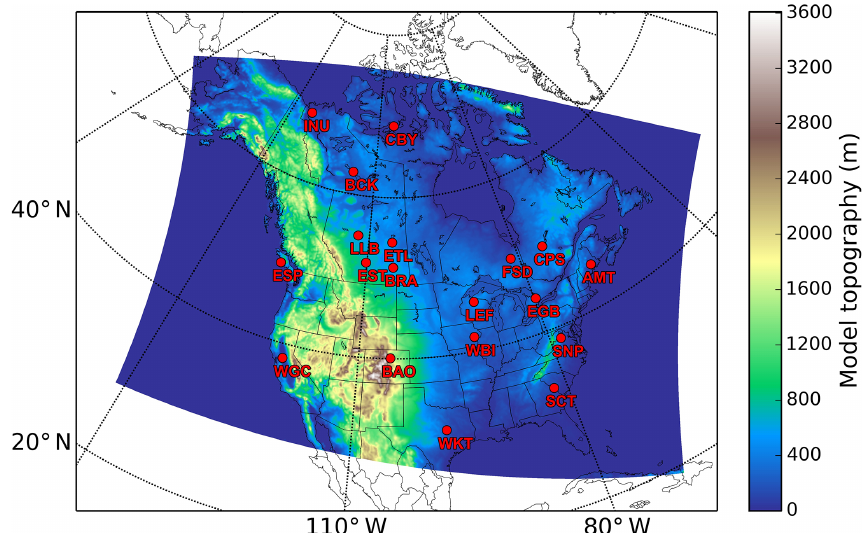
Figure 1. Model topography of the regional model with 10km horizontal grid spacing and CO 2 measurement sites used in this study (red dot with site